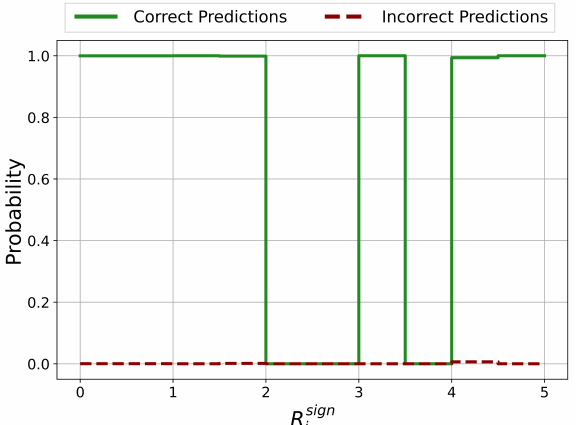
Figure 11. Probability distribution of ratios between the number of negative Relevance scores and the number of positive Relevance scores for correct (green solid line) and incorrect (red dashed line) predictions. For all existing values of R sign , the probability of the prediction being correct is i practically 1.